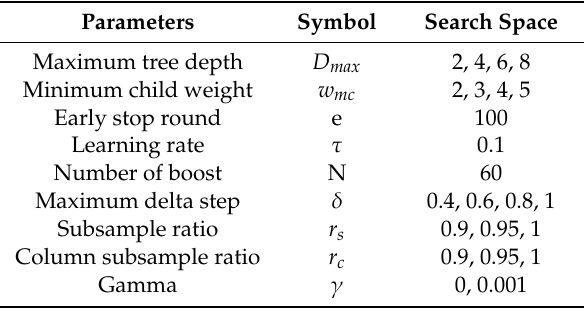
Table 1. Searching space of XGBoost